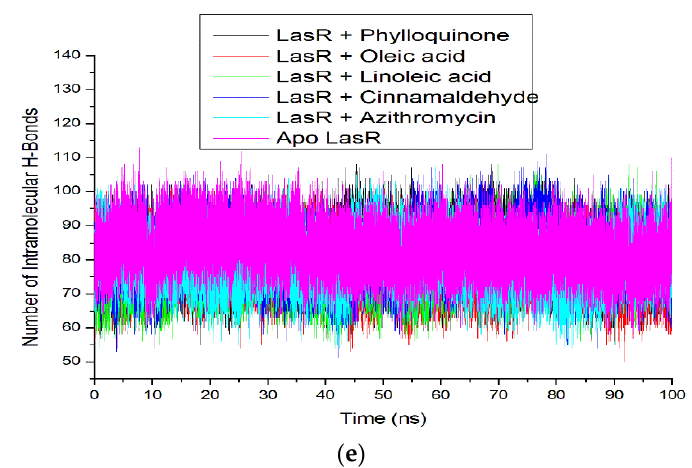
Figure 10. ( a ) Root mean square deviation (RMSD), ( b ) root mean square fluctuations (RMSF), ( c ) radius of gyration (RoG), ( d ) solvent accessible surface area (SASA), and ( e ) number of intramolecular hydrogen bonds plots of comparison between LasR and top three compounds, azithromycin, and cinnamaldehyde determined over 100 ns molecular dynamics simulation.